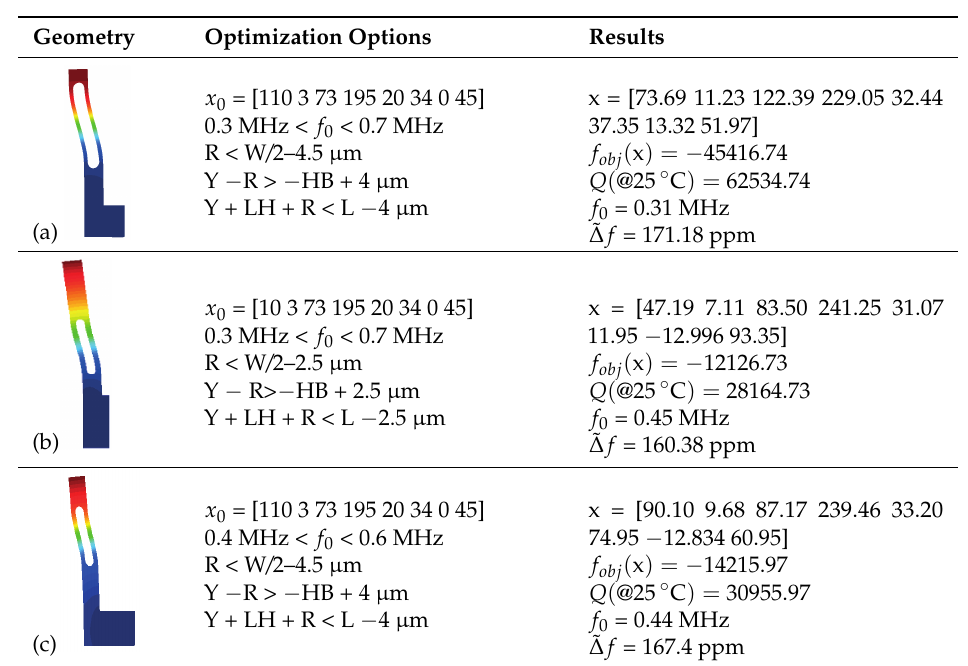
Table 4. Optimal geometries computed through the CMA-ES optimization algorithm starting from the geometry shown in Figure 9. The objective function reads: f obj = 100 ˜ ∆ f − Q ( @25 ◦ C). All the geometric dimensions are reported in µ m and the angles in